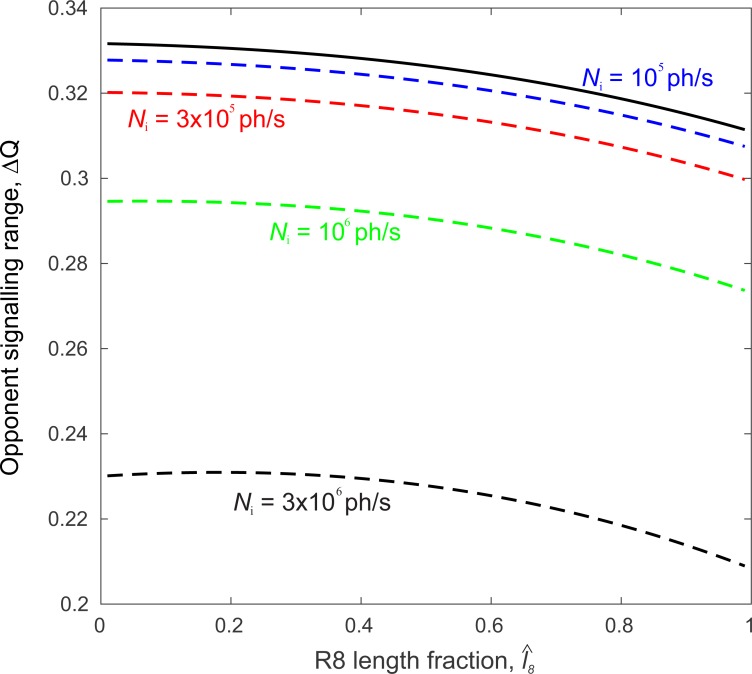
Polarization-opponent unit’s signal range, ΔQ, is largest when the R8 length fraction, \documentclass[12pt]{minimal}
\usepackage{amsmath}
\usepackage{wasysym}
\usepackage{amsfonts}
\usepackage{amssymb}
\usepackage{amsbsy}
\usepackage{upgreek}
\usepackage{mathrsfs}
\setlength{\oddsidemargin}{-69pt}
\begin{document}
}{}${\hat {l}}_{8}$\end{document}l ˆ8, is vanishingly small and, without transduction unit saturation (solid curve) does not depend on incident photon flux, Ni.Saturation progressively decreases ΔQ with increasing Ni (dashed curves). Rhabdom length, l = 100 µm. Degree of polarization d = 0.1. Incident photon flux, Ni: 1 × 105 (blue), 3 × 105 (red), 1 × 106 (green) and 3 × 106 (black) photons s−1.